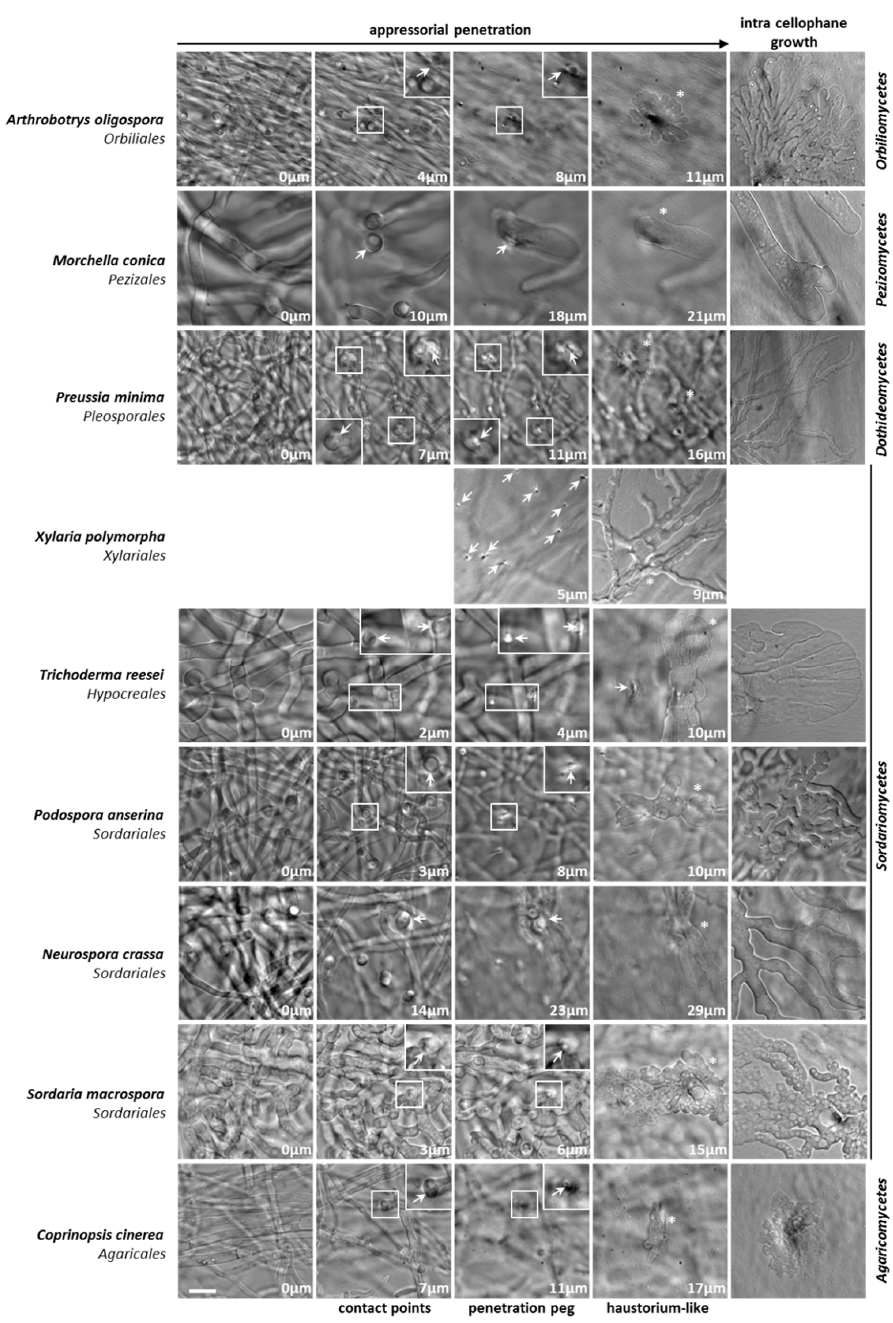
Figure 2. Appressoria in Dikarya . For a selection of the representative species of the main groups of fungi endowed with an appressorium to penetrate cellophane, the main steps of appressorium-based cellophane penetration have been represented. From left to right, the first four columns represent successive z-planes of the same field of view. The distances from the initial z-plane are indicated. For Xylaria polymorpha , the mycelium was too dense to allow imaging of the first steps of appressorial development. To image the “penetration peg” and the “haustorium-like growth” stages in X. polymorpha , pictures were taken after on-top-growing mycelium removal. For each appressorium imaged, arrows indicate the contact points and the penetration peg corresponding to the haustorium-like growth (*) in the third column; for X. polymorpha , arrows point to every observable penetration peg. Last column ( right ) shows in-depth intra-cellophane mycelial development. For X. polymorpha , this step is already represented in the previous “haustorium-like growth” column. Scale bar = 10µm. Magnification in the upper insets is 1.7×.